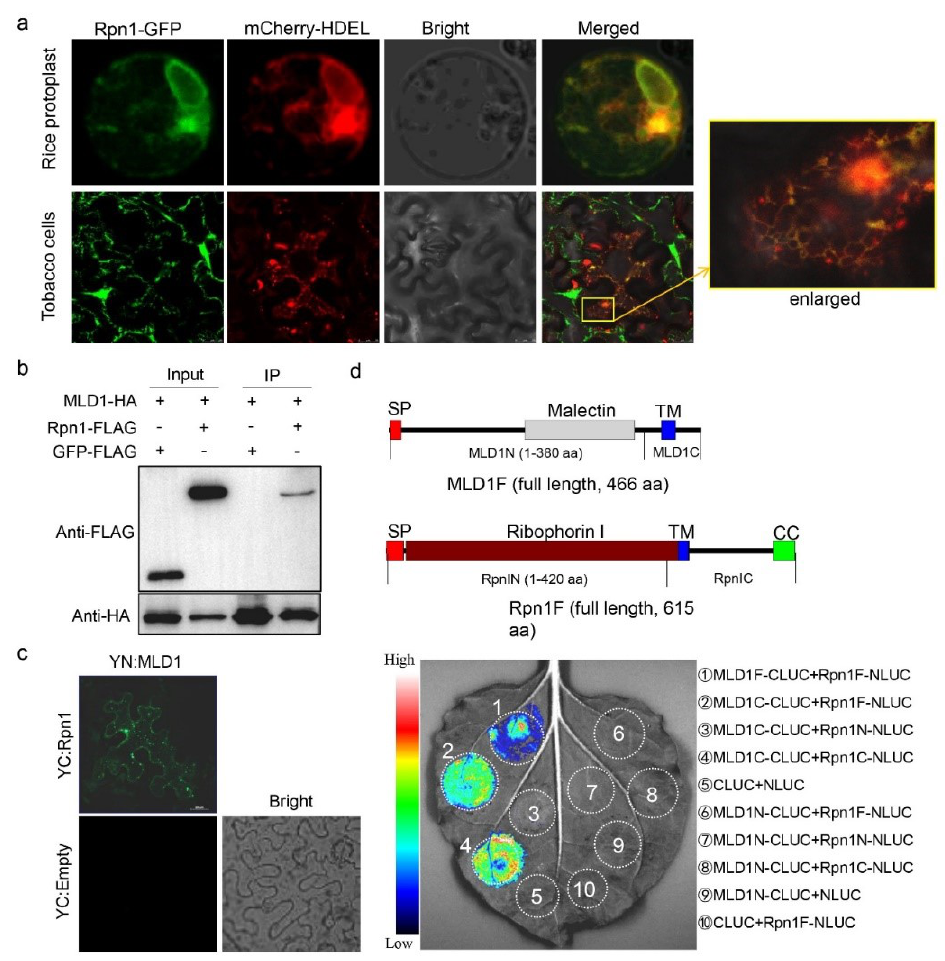
Figure 4. Rice ribophorin I (OsRpn1) localizes in the ER and interacts with OsMLD1. ( a ) Subcellular localization of OsRpn1 in rice protoplasts and Nicotiana benthamiana leaves. ( b ) Co-IP assays for the interactions of OsMLD1 with OsRpn1 in vivo . Rpn1-GFP (~110 kD), MLD1-FLAG (~50 kD), and GUS-FLAG (~75 kD) were expressed in Nicotiana benthamiana. Co-IP was performed using GFP-binding beads. Proteins were detected with antibodies as indicated. Similar results were obtained in three independent experiments. ( c ) Interactions between OsMLD1 and OsRpn1 shown by BiFC assays in N. benthamiana leaf epidermal cells. BiFC fluorescence is indicated by the eYFP signal. The eYFP signal was not detected in the corresponding negative controls. ( d ) Firefly LUC complementation imaging (LCI) assay detecting the interaction between OsMLD1 and OsRpn1. The colored scale bar indicates the luminescence intensity. NLUC indicates the N-terminus of LUC, while CLUC indicates the C-terminus of LUC.